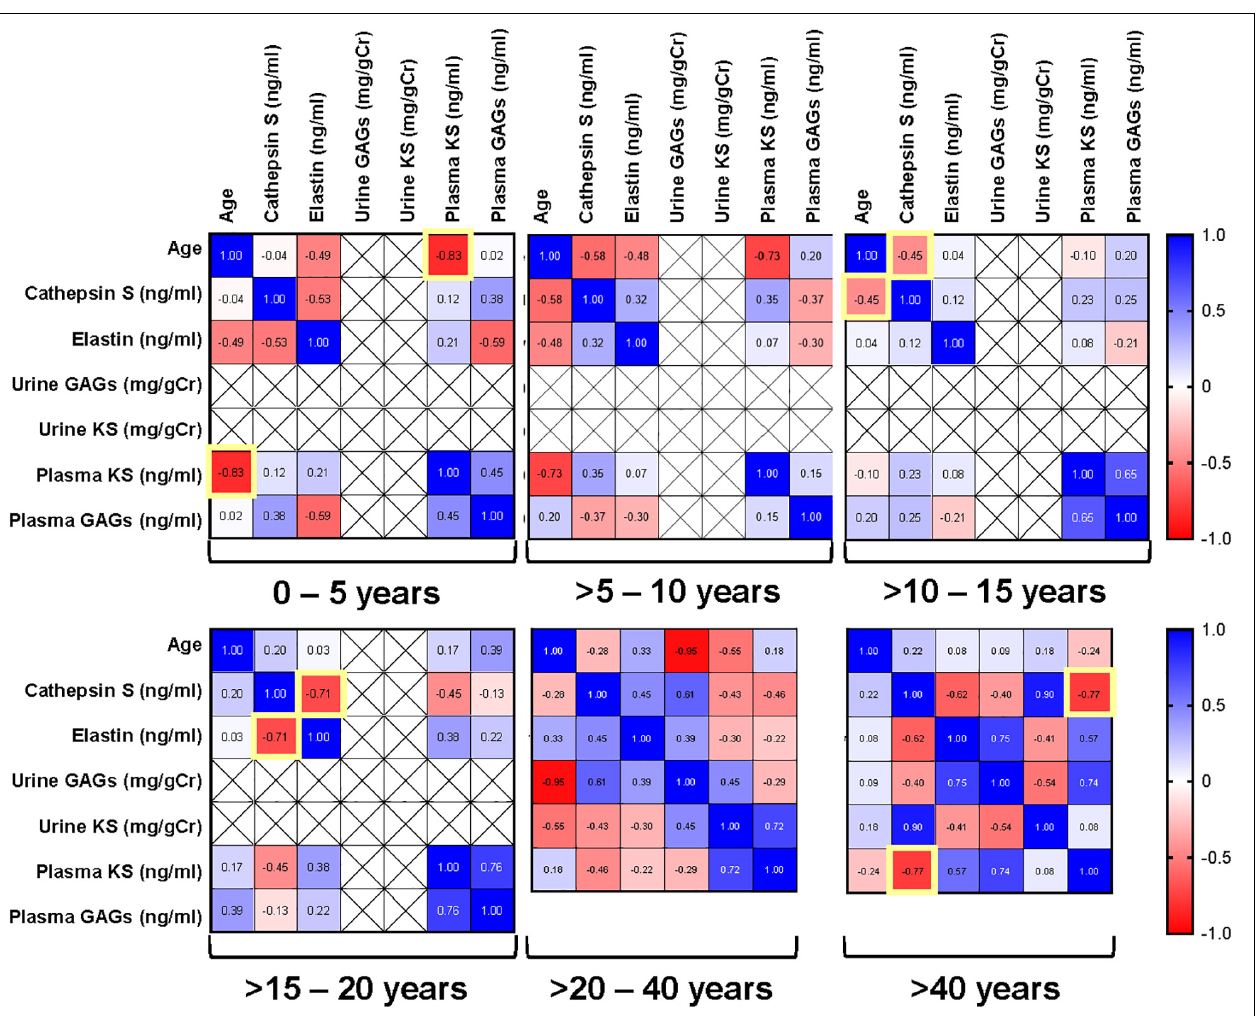
FIGURE 1 | Pairwise Pearson correlation matrix of age, keratan sulfate (KS), glycosaminoglycans (GAGs), cathepsin S and elastin in normal samples stratified by age groups. Blue indicates positive correlation, and red indicates negative correlation. Darker colors are associated with stronger correlation coefficients. Yellow boxes indicate significant